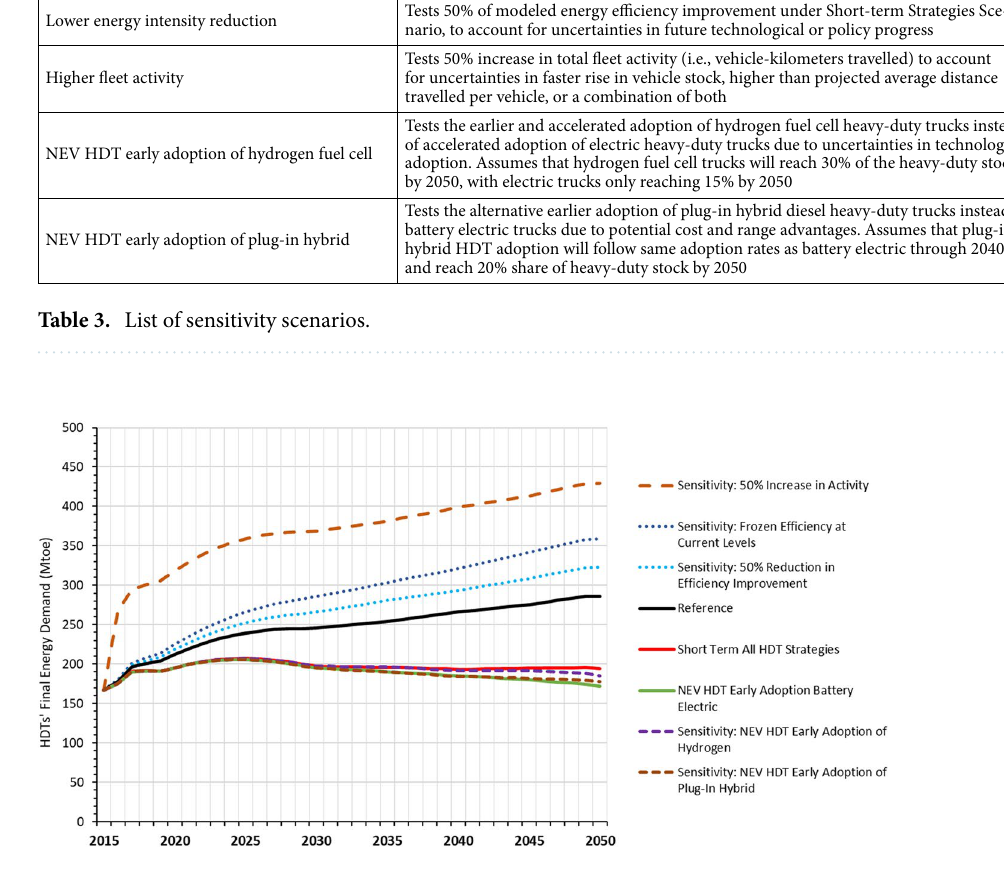
Figure 8. China’s HDTs’ final energy demand results by sensitivity analysis